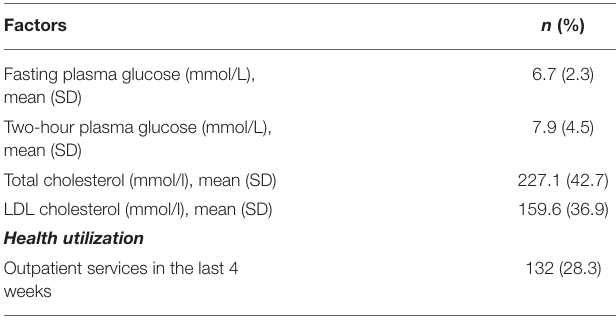
TABLE 1 | Characteristics of participants with hypertension at baseline ( n = 467).